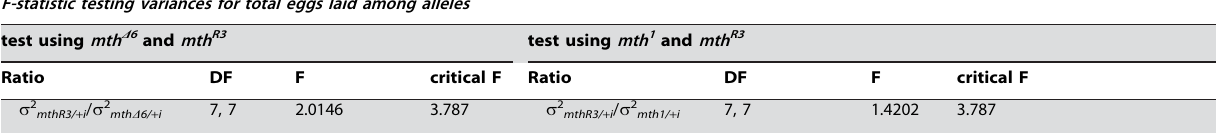
F-statistictestingvariancesfortotaleggslaidamongalleles